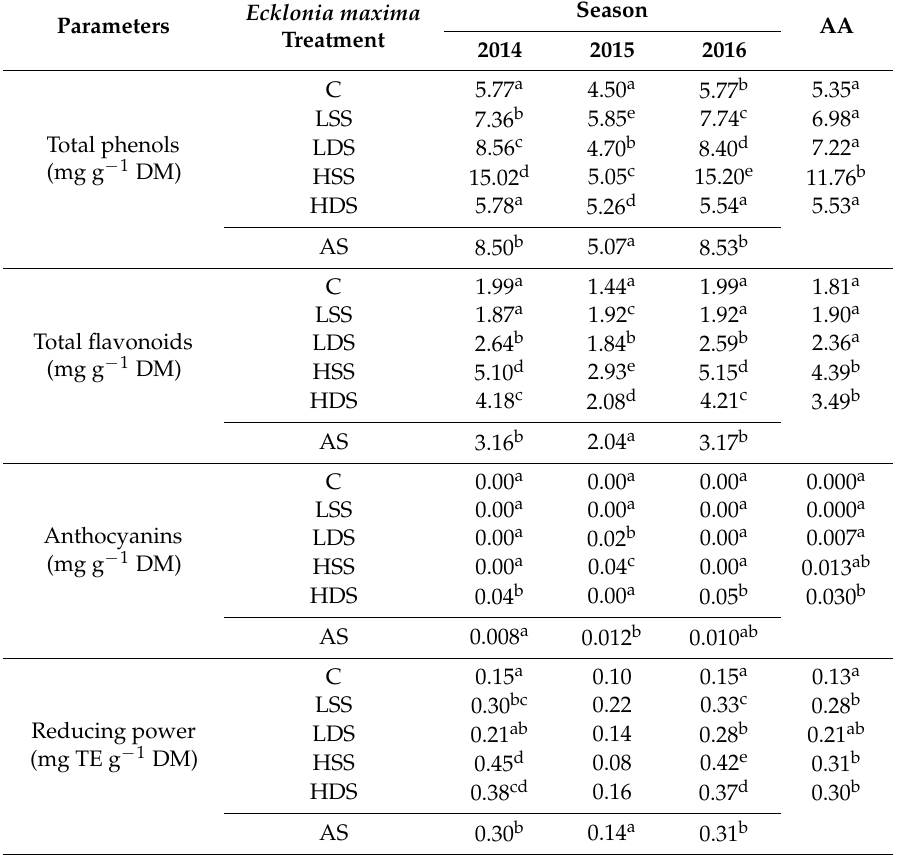
Table 6. Effect of Ecklonia maxima extract (Kelpak) treatment on the antioxidant potential in soybean seeds (average from